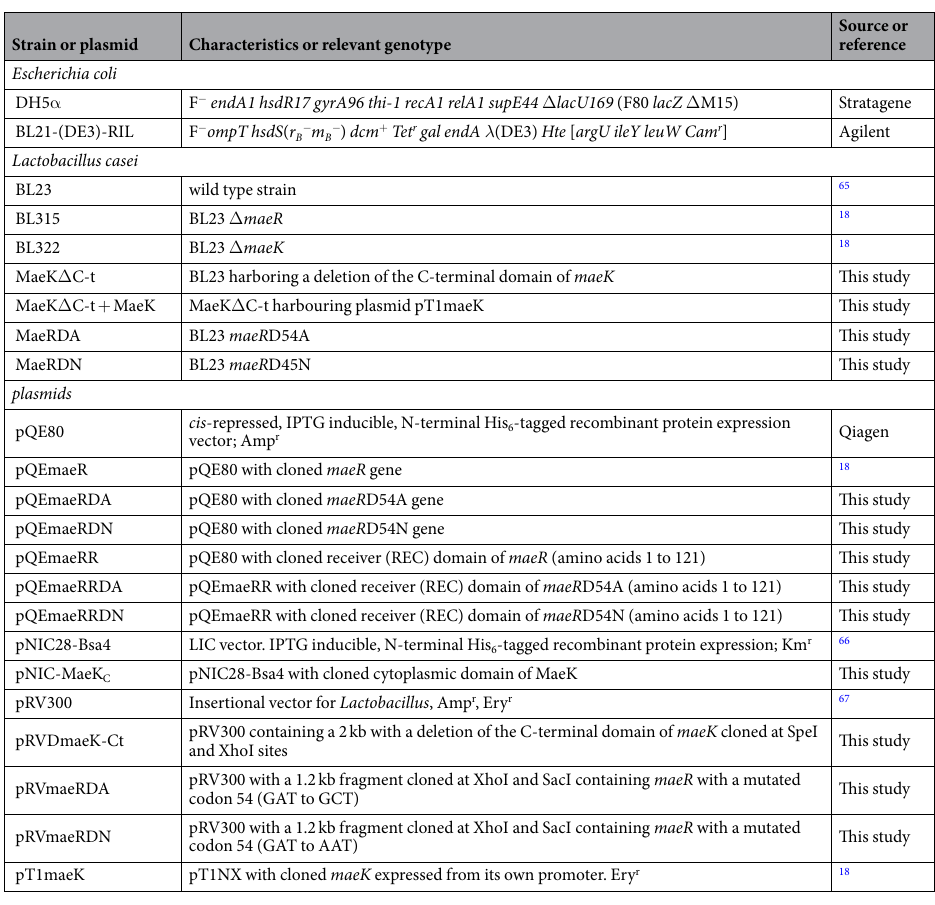
Table 2. Strains and plasmids used in this